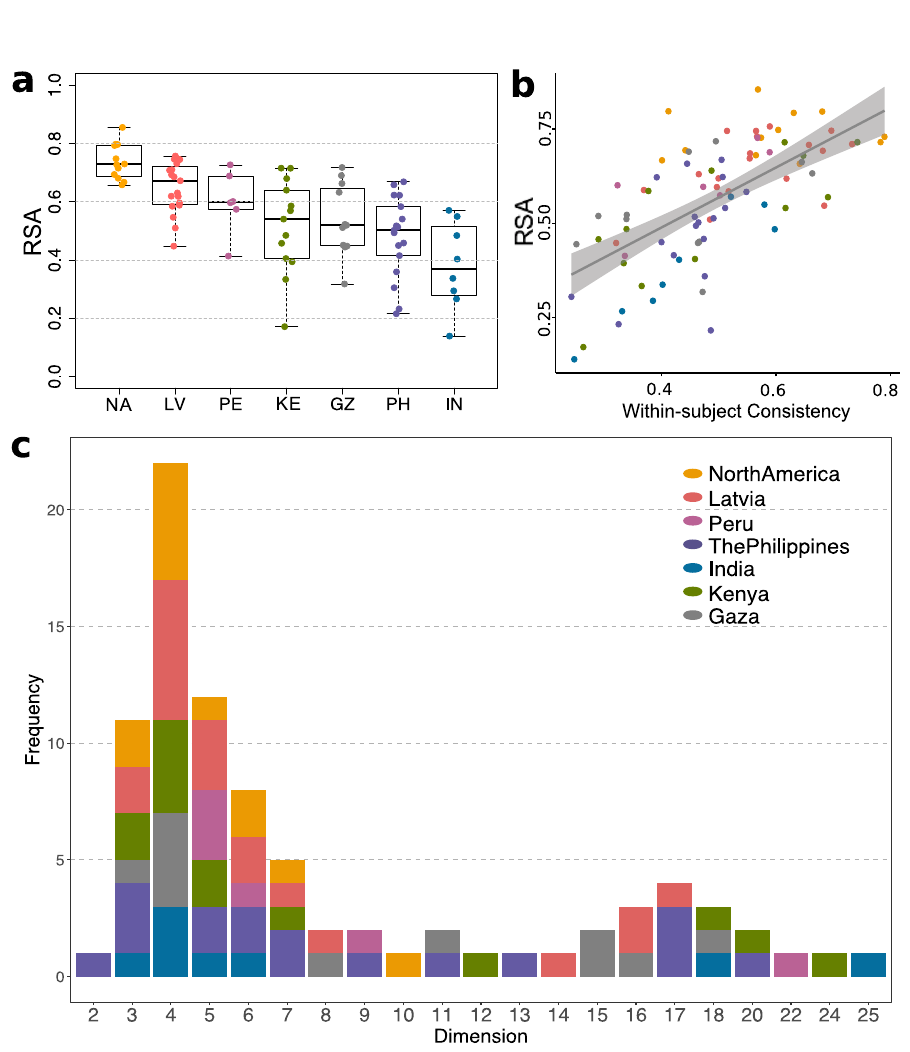
Fig. 6 Dimensionality of trait attributions from faces across different samples. a Eigenvalue decomposition. Dots plot the eigenvalues of the fi rst 10 factors across seven samples, indicated by different colors. b Tucker indices of factor congruence. Columns indicate the four dimensions found in Study 1: warmth (W), competence (C), femininity (F), and youth (Y). Rows indicate the four factors derived from the samples in North America (NA), Latvia (LV), Peru (PE), the Philippines (PH), Kenya (KE), India (IN), and Gaza (GZ). Numbers report the Tucker indices (with orthogonal Procrustes rotation). The color scale shows the sign and strength of the indices. Statistical signi fi cance (p-value in parentheses) was obtained using permutation test (with orthogonal Procrustes rotation, and permuting both the rows and columns of the compared factor loading matrix 87 over 1000 iterations). c Individual within-subject consistency by sample (assessed with Pearson ’ s correlations). Every participant in Study 2 had rated a subset of 20 traits twice for all faces to provide an assessment of within-subject consistency ( n s = 12, 19, 6, 11, 17, 13, 8 participants from left to right columns who had complete data after exclusion). Boxplots indicate the minima (bottommost line), fi rst quartiles (box bottom), medians (line in box), third quartiles (box top), and maxima (topmost line) of the within-subject consistency. Source data are provided as a Source Data fi le.